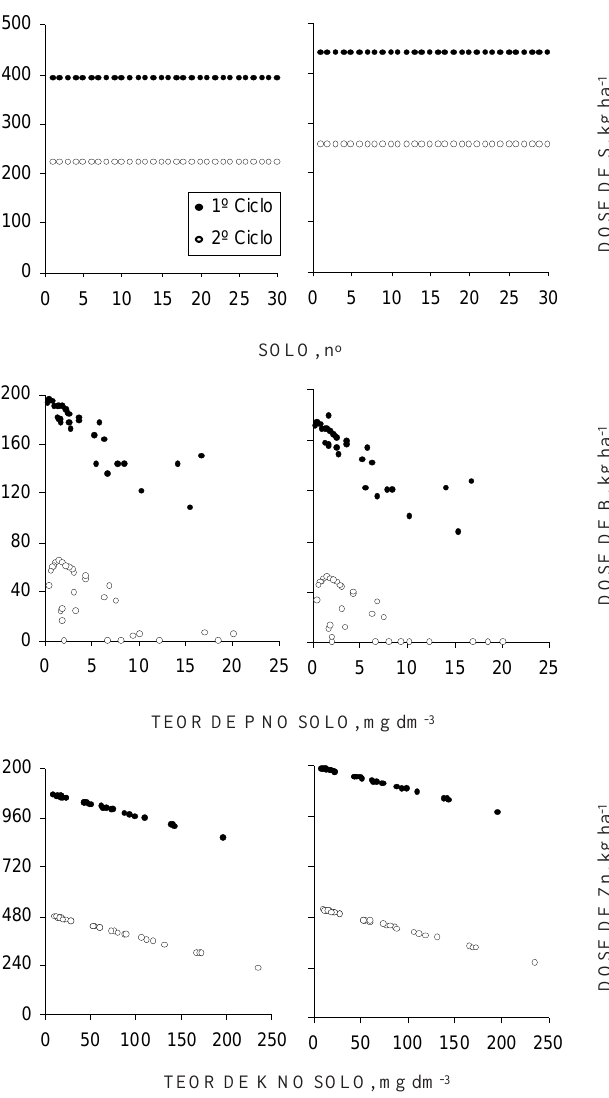
Figura 6. Doses de N, P O e K O recomendadas pelo Figura 7. Doses de enxofre, boro e zinco recomen- 2 5 2 FERTICALC (cid:210)(cid:210)(cid:210)(cid:210)(cid:210) -Bananeira, em função dos teores dadas pelo FERTICALC (cid:210)(cid:210)(cid:210)(cid:210)(cid:210) -Bananeira, em fun- desses nutrientes no solo, para bananeiras dos ção dos teores desses nutrientes no solo, para grupos AAA e AAB, no primeiro e no segundo bananeiras dos grupos AAA e AAB, no primei- ciclo (Para nitrogênio, considerou-se o solo ro e no segundo como variável independente, por ainda não se dispor de análise de solo para esse nutriente).